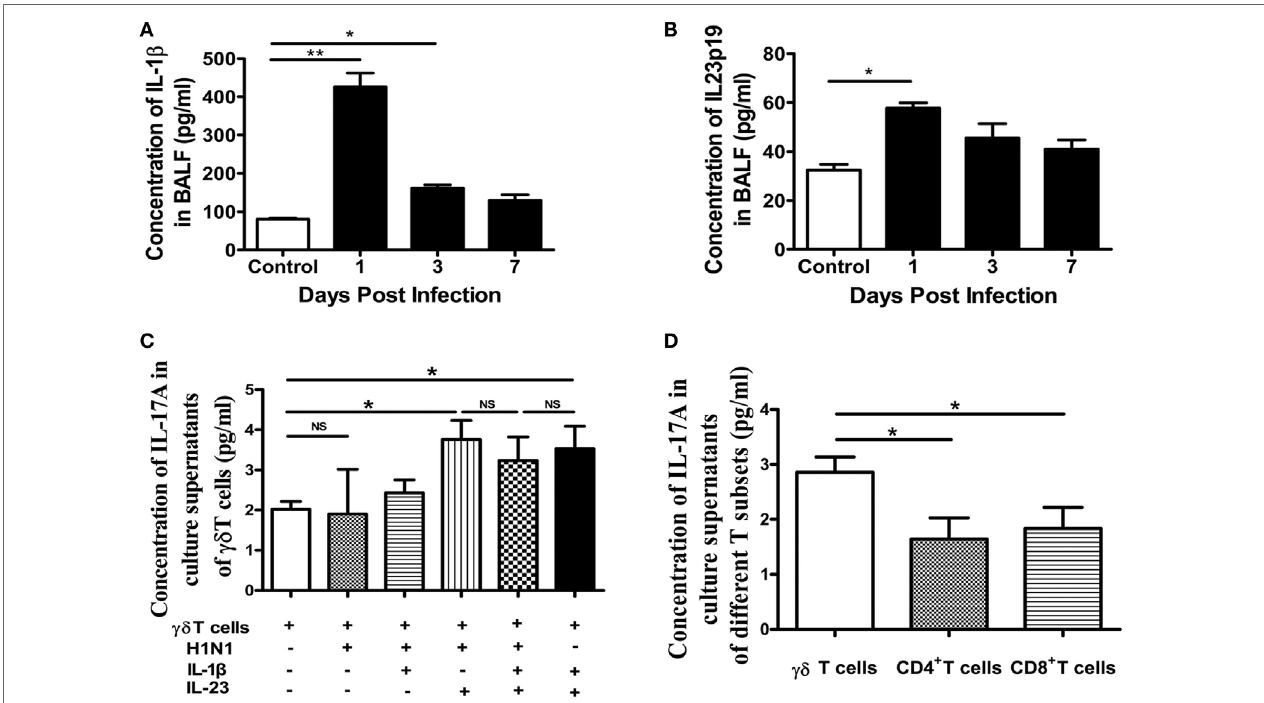
FigUre 4 | Expression of IL-17A by γδ T cells was induced by IL-1 β and/or IL-23. Concentrations of IL-1 β (a) and IL-23 (B) in BALF of the control or infected mice at the indicated dpi were quantified using ELISA. (c) MACS-sorted lung-derived γδ T cells from uninfected mice were stimulated with H1N1 virus (10 4 TCID 50 /100 μ l, 5 µl/well), IL-1 β (10 ng/ml), and/or IL-23 (10 ng/ml) for 36 h, as indicated. Concentrations of IL-17A in the supernatants were quantified using ELISA. (D) MACS- sorted infected lung-derived γδ T cells, CD4 + T cells, or CD8 + T cells at 1 dpi were cultured for 36 h, and concentrations of IL-17A in the supernatants were quantified using ELISA. * p < 0.05, ** p <